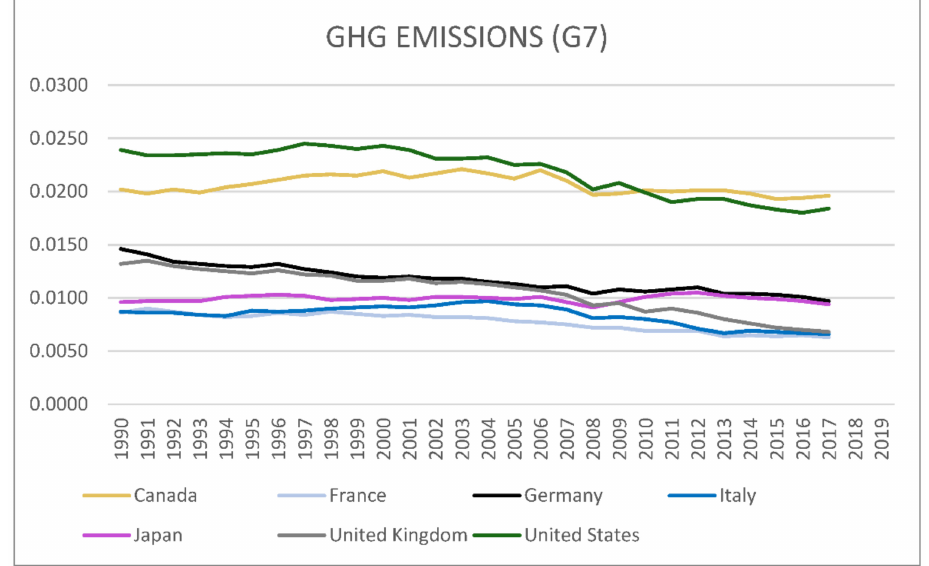
Figure A2. Greenhouse gas emissions for G7 countries. Source: World Bank